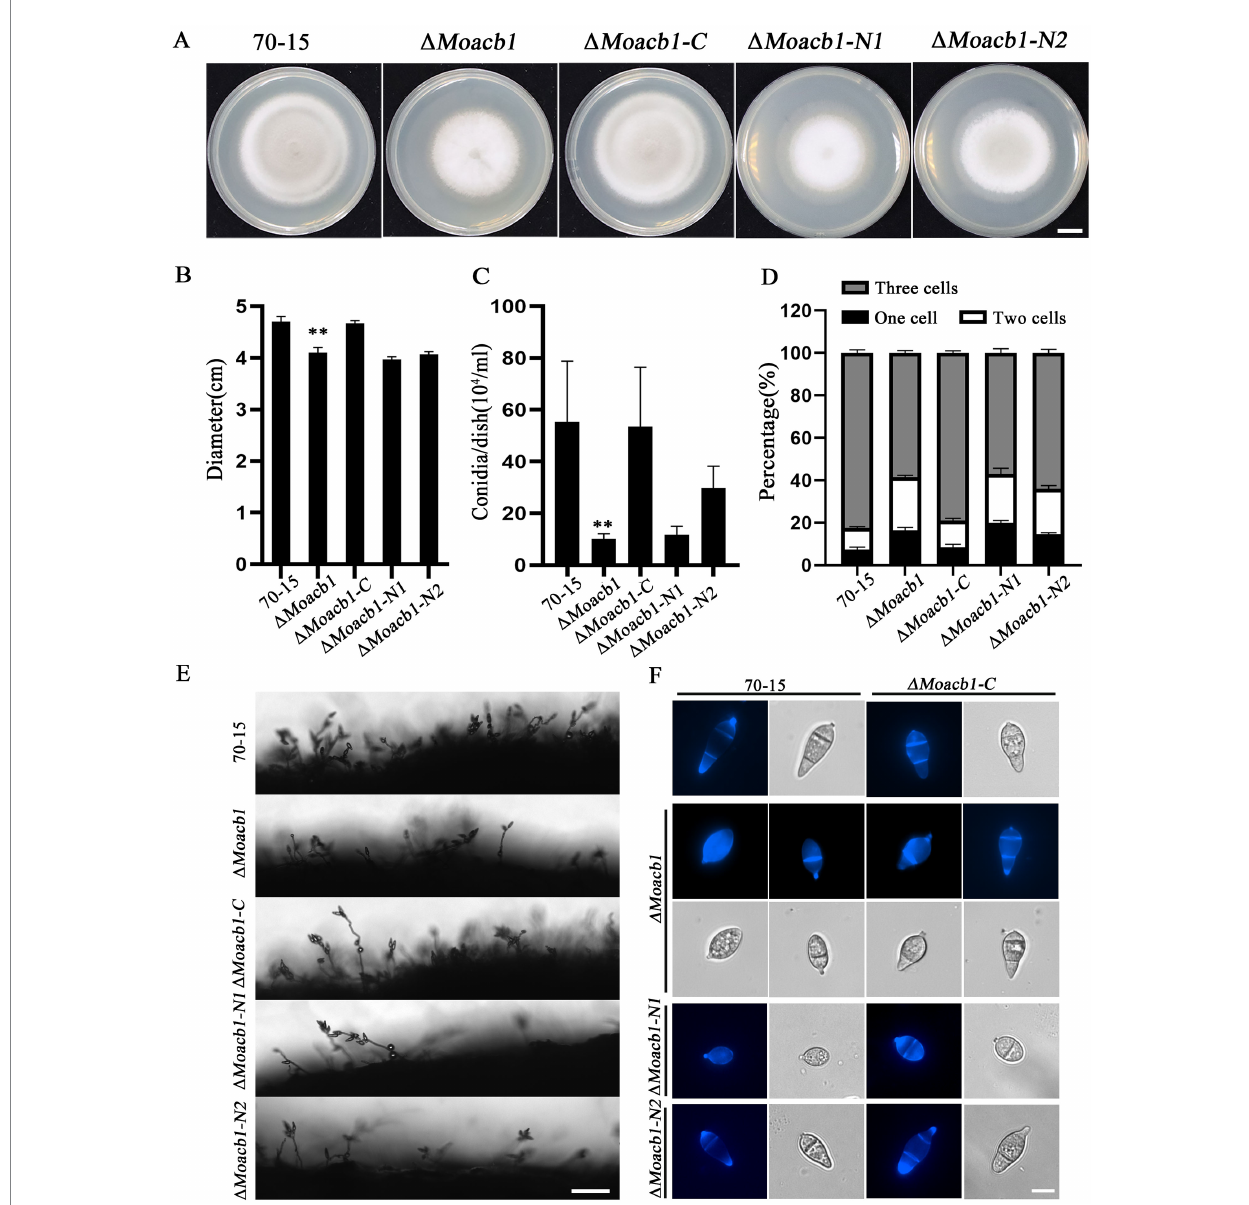
FIGURE 2 MoAcb1 is involved in conidial development of M. oryzae . (A) Conidial morphology of five strains grown in CM for 8 days. Bar, 1 cm. (B) Measurement and analysis of the colony diameter of five strains grown in CM for 8 days, with the standard deviation indicated by error bars. T -test was used to test for significant differences. ** p < 0.01. (C) The conidial yields of five strains grown in CM for 8 days, with the standard deviation indicated by error bars. T -test test was used to test for significant differences. ** p < 0.01. (D) The three different types of conidia were statistically analyzed in the five strains, with the standard deviation indicated by error bars. T -test was used to test for significant differences. (E) Observed conidiophore of the five strains under an electron microscope. Bar, 50 μ m. (F) Conidia of the five strains were stained with calcofluor white (CFW), and the septum was stained blue. Bar, 10 μ